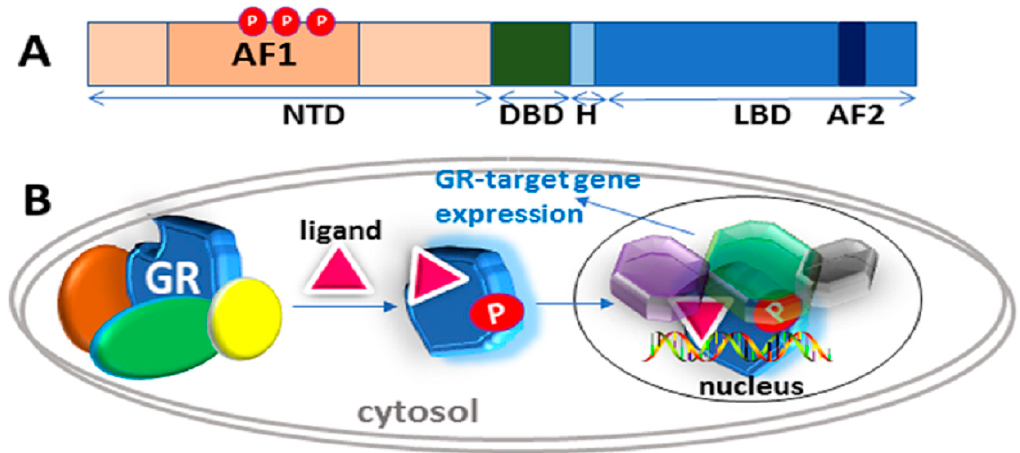
Figure 1. Classical action of the glucocorticoid signaling mediated by the glucocorticoid receptor (GR). ( A ) A topological diagram of human GR protein showing major functional domains and major known AF1 phosphorylation (P) sites (other GR sites not shown) [6]. NTD, N-terminal domain; DBD, DNA binding domain; H, Hinge region, LBD, Ligand binding domain. ( B ) Unliganded receptor is located in the cytosol associated with several heat shock and other chaperone proteins including HSP90, HSP70, CyP-40, P23, and FKBPs (shown by different colors around GR). Ligand binding leads to conformational alterations in the GR, and by doing so GR dissociates from these associated proteins, and ligand bound GR is free to translocate to the nucleus. This process appears to be phosphorylation (P) dependent. Once in the nucleus, GR binds to site-specific DNA binding sequences and interacts with several other coregulatory proteins (shown by different colors and shapes around GR), and subsequently leads to transcriptional regulation. Based on reference [10].